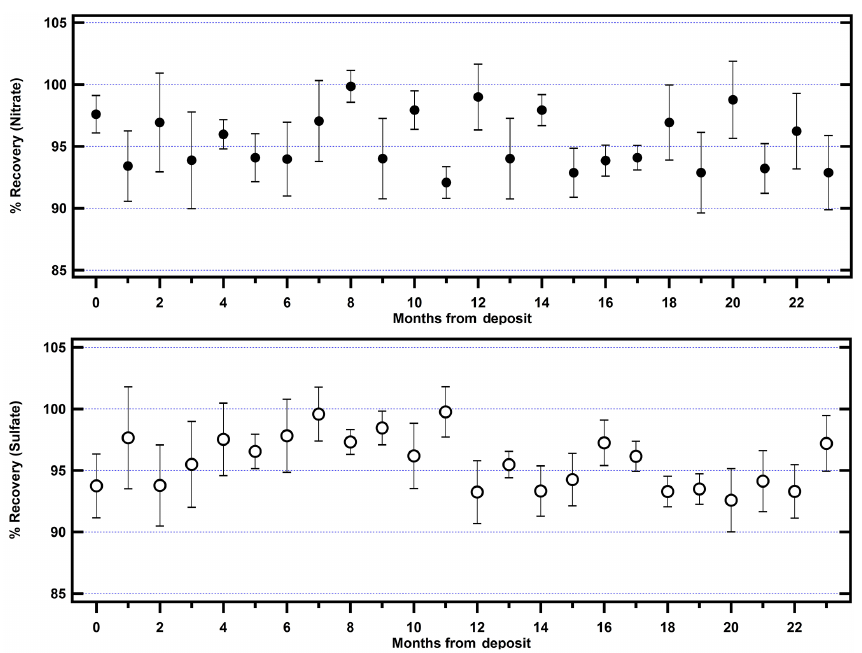
Figure 3. Percent recovery of deposited standard in wells after different plate storage periods (up to 23 months). The error bars represent the standard deviation of data from five well plates.